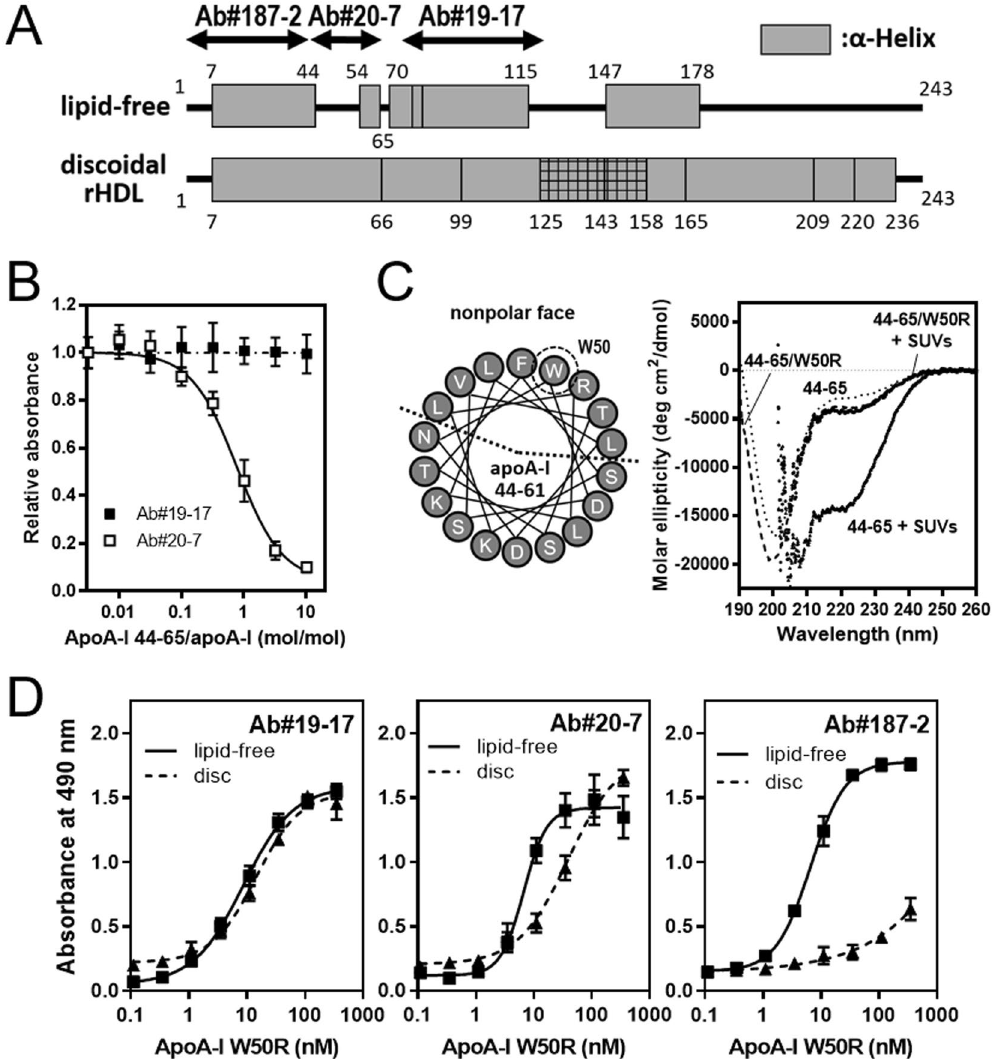
Figure 5. Effect of W50R mutation in apoA-I on reactivity of mAbs. ( A ) Locations of α -helical segments in lipid-free and discoidal HDL apoA-I 21, 54 . The cylinders represent α -helices, and the lines indicate random coil structure. The crosshatched region (residues 125–158) indicates coexisting helical and disordered loop conformations. The epitope-containing segments for Ab#19-17, Ab#20-7, and Ab#187-2 were shown as arrowed lines. ( B ) Competitive ELISA for binding of Abs#19-17 and Ab#20-7 to lipid-free apoA-I (35 nM) with increasing concentrations of apoA-I 44–65 peptide. The absorbance at 490 nm in the absence of apoA-I 44–65 was normalized to 1.0. ( C ) Helical wheel diagrams of residues 44–65 of apoA-I. Trp-50 is located on the center of non-polar face of amphipathic α -helix (left). Far-UV CD spectra of apoA-I 44–65 and W50R variant peptides in the absence or presence of egg phosphatidylcholine small unilamellar vesicles (SUVs) (right). ( D ) Sandwich ELISA for binding of mAbs to full-length apoA-I W50R variant in the lipid-free state or on discoidal